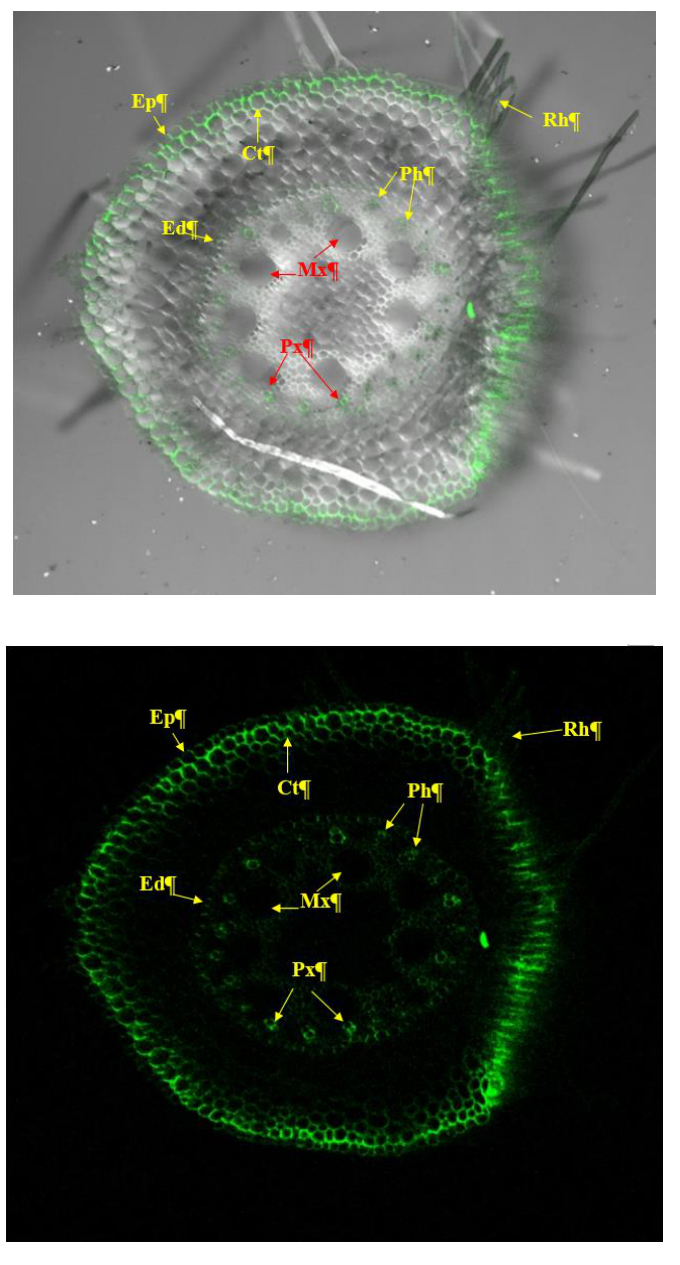
Figure 4. Localization of GFP-tagged Pseudomonas geniculata MF-84 in maize root tissues (endophyticnature) under a confocal scanning laser microscope (10 ×